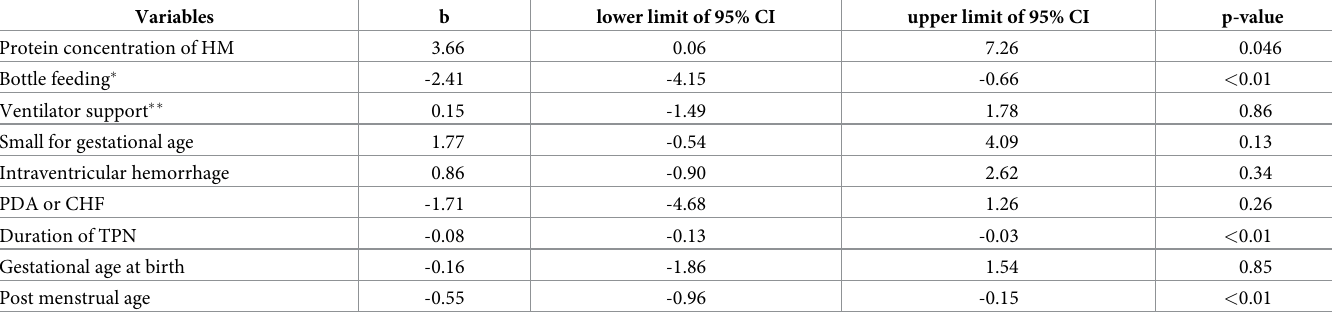
Table 4. Relationship between protein concentration in human milk and body weight gain: Results from a generalized estimating equation. Variables